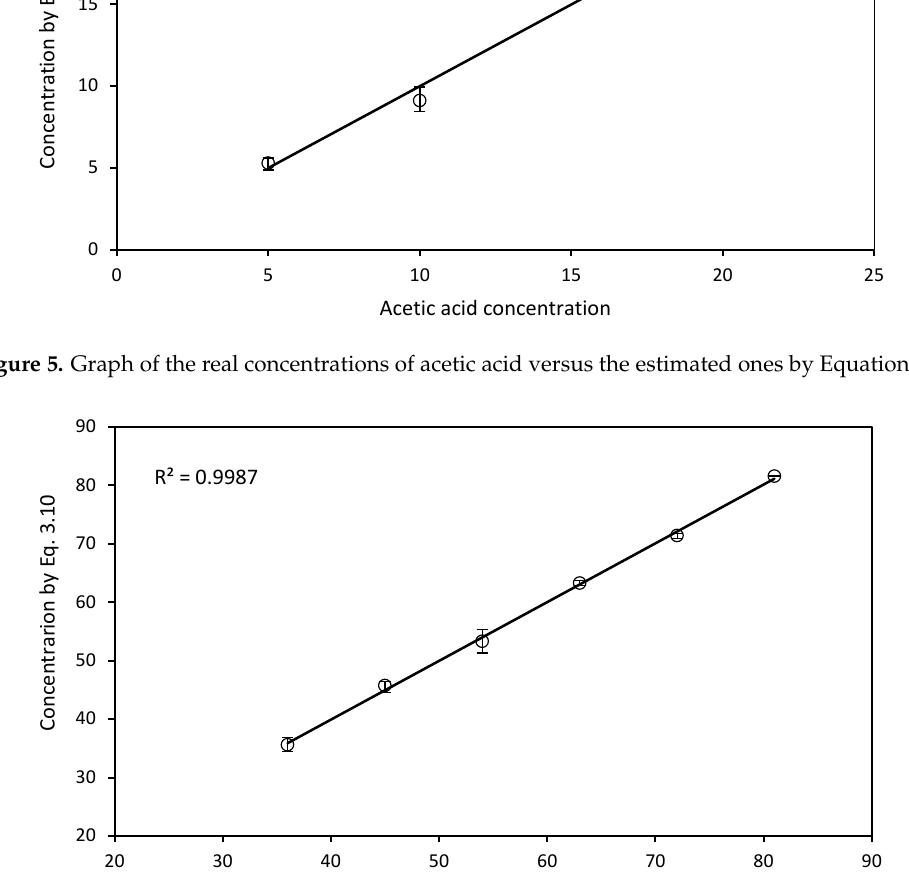
R² = 0.9865 R² = 0.9865